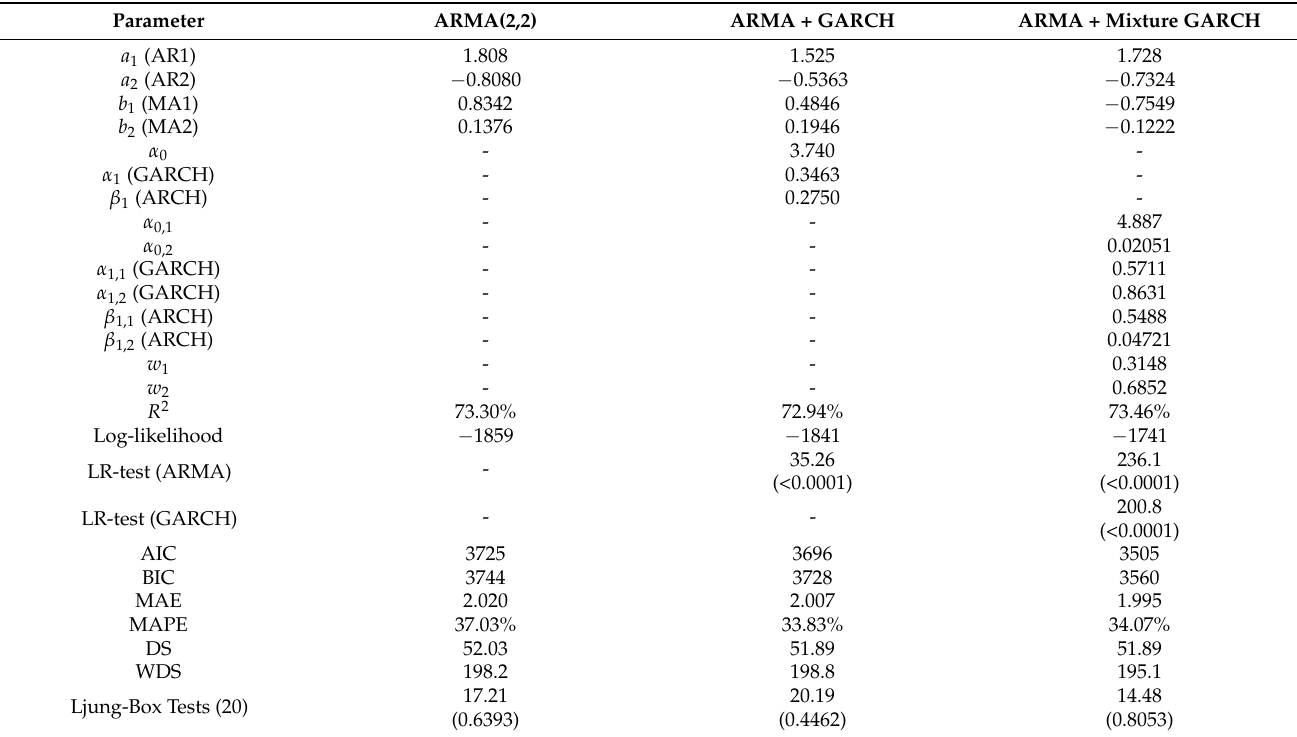
Table 1. Estimated parameters and performance measures for the first wind speed data sample.